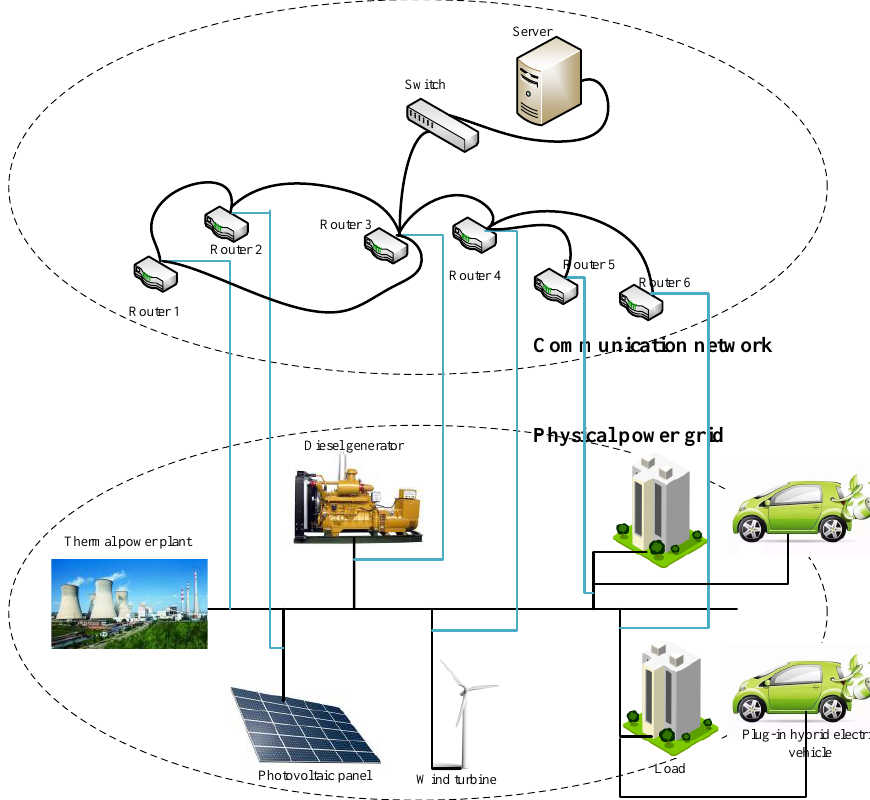
Figure 1. The sketch of cyber–physical power